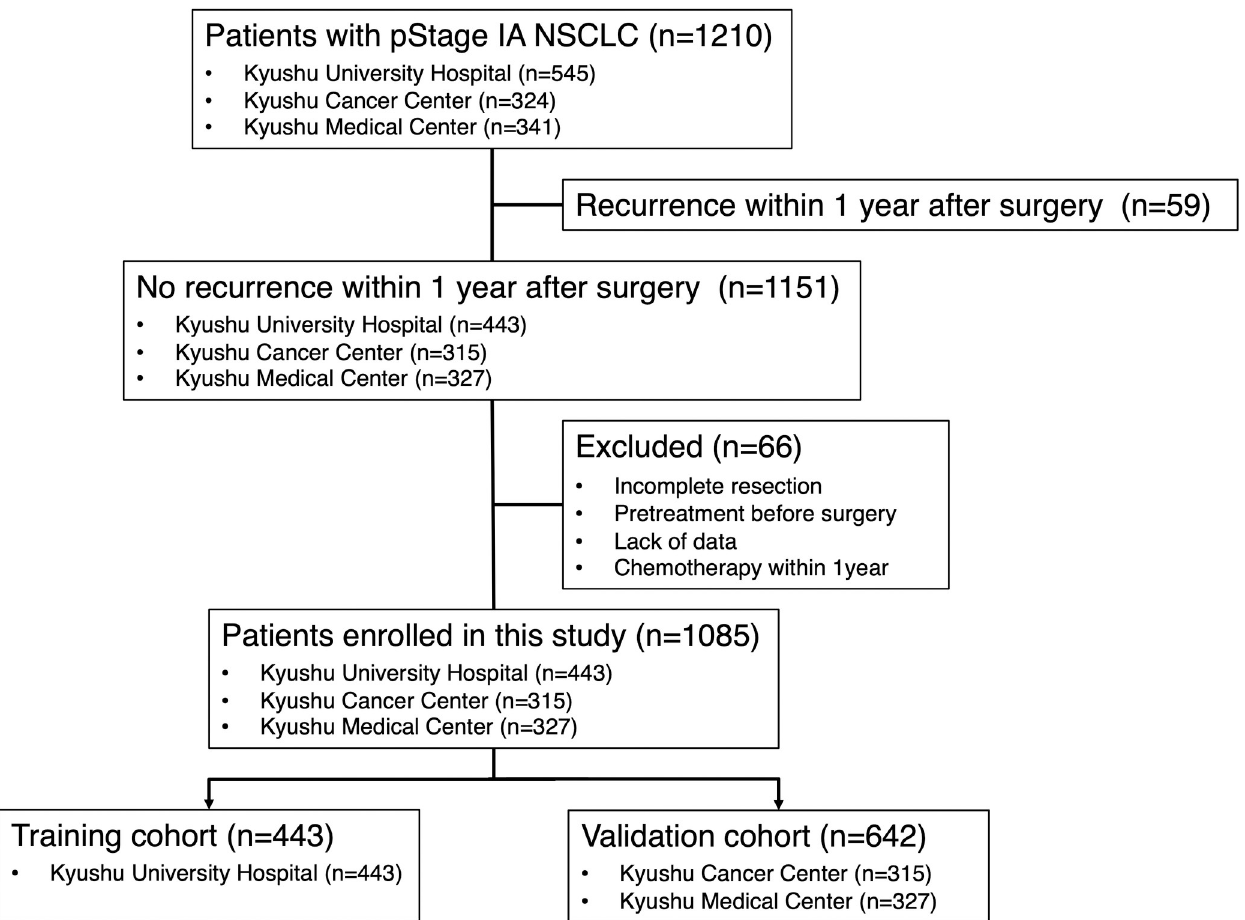
Fig 1. Consort diagram of patient selection. pStage, pathological stage; NSCLC, non-small cell lung carcinoma.